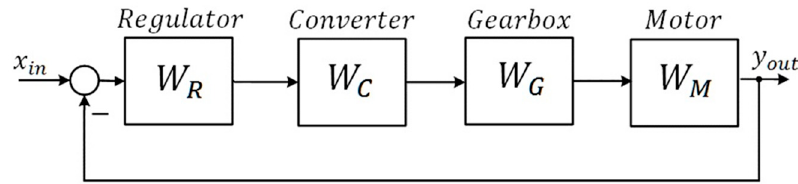
Figure 7. ACS functional diagram.